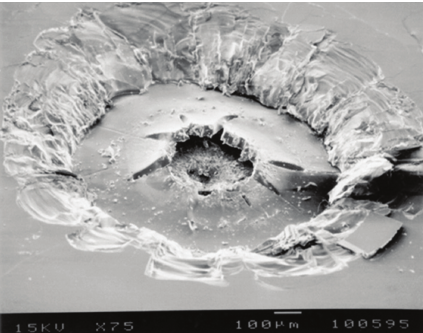
Figure 1: Impact of debris on a solar cell (CNES property).